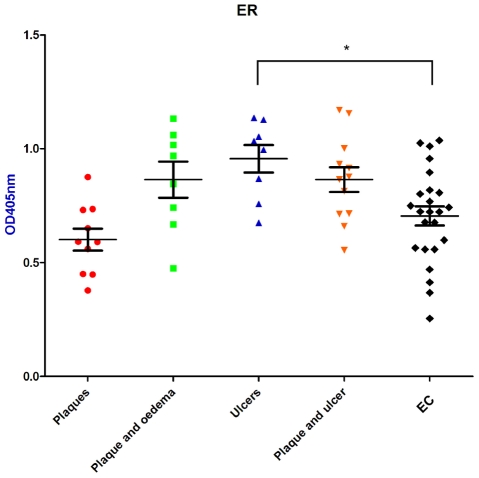
Analysis of BU patient serum reactivity by disease state.Patient antibody responses were analysed by disease state for the mycolactone polyketide synthase ER domain. Means and SEM of each group are shown. * = p<0.05.